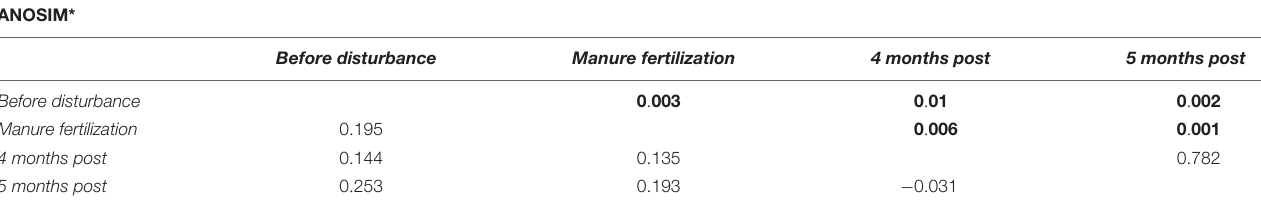
TABLE 1 | Microbial community composition response to manure fertilization disturbance measured by differences in beta-diversity between pre- and post-disturbance samples within the Kewaunee River watershed. ANOSIM* Before disturbance Manure fertilization 4 months